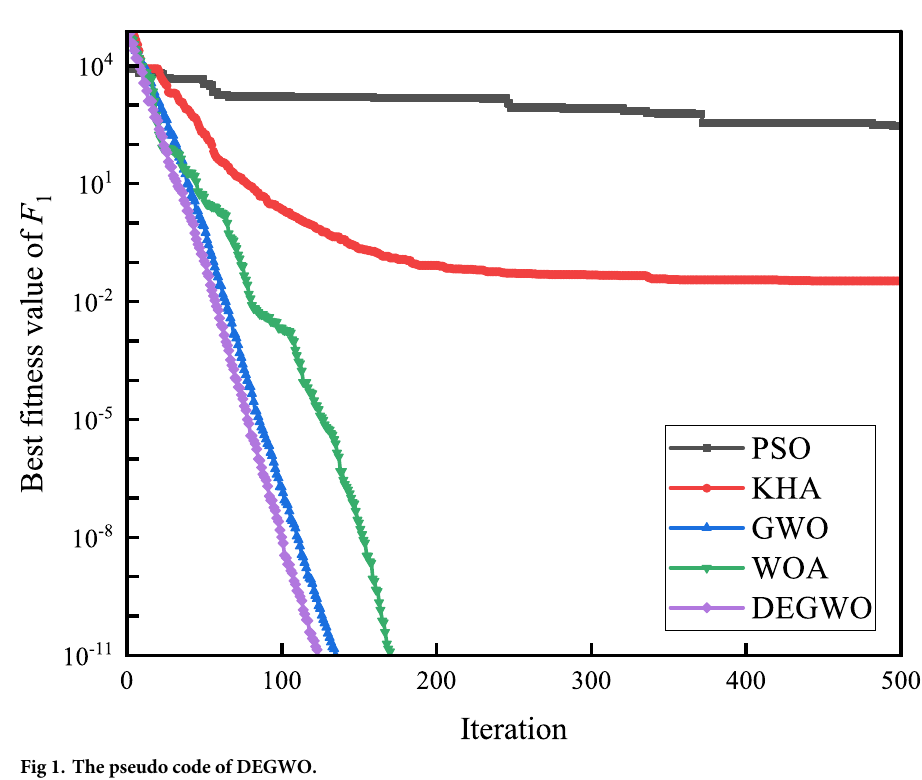
Fig 1. The pseudo code of